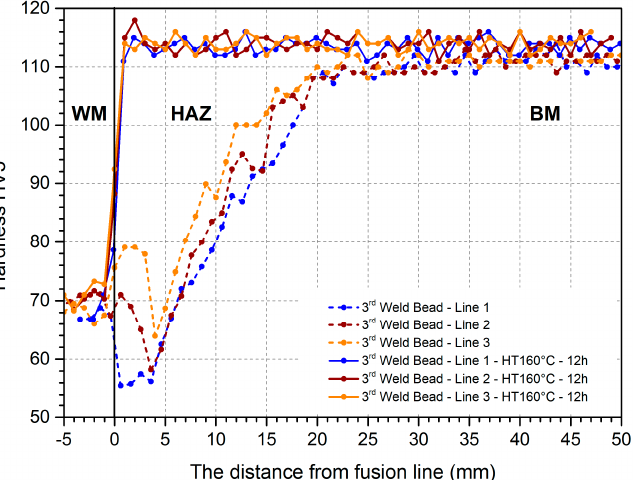
Figure 12. Measured hardness values in the weld metal, HAZ and base material for weld 1 (with preheating at 75 °C) in the zones of lines 1, 2 and 3 after welding and after age-hardening at 160 °C for 12 h.